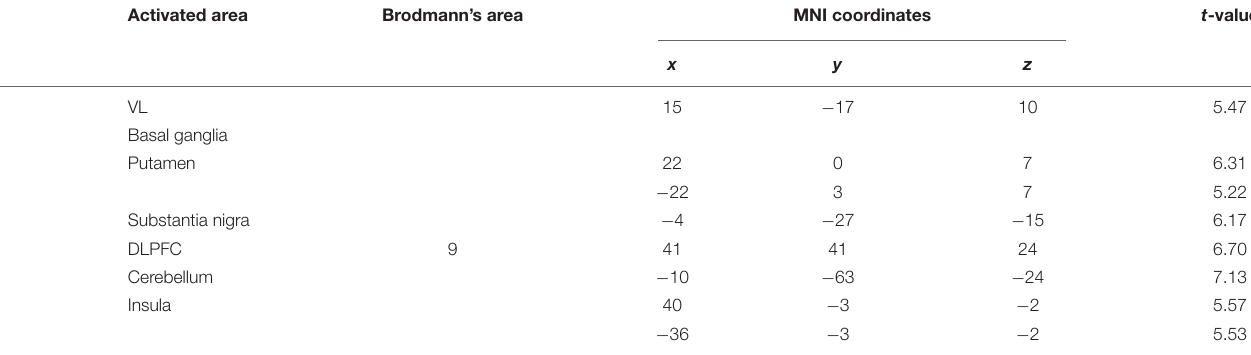
Frontiers in Aging Neuroscience |